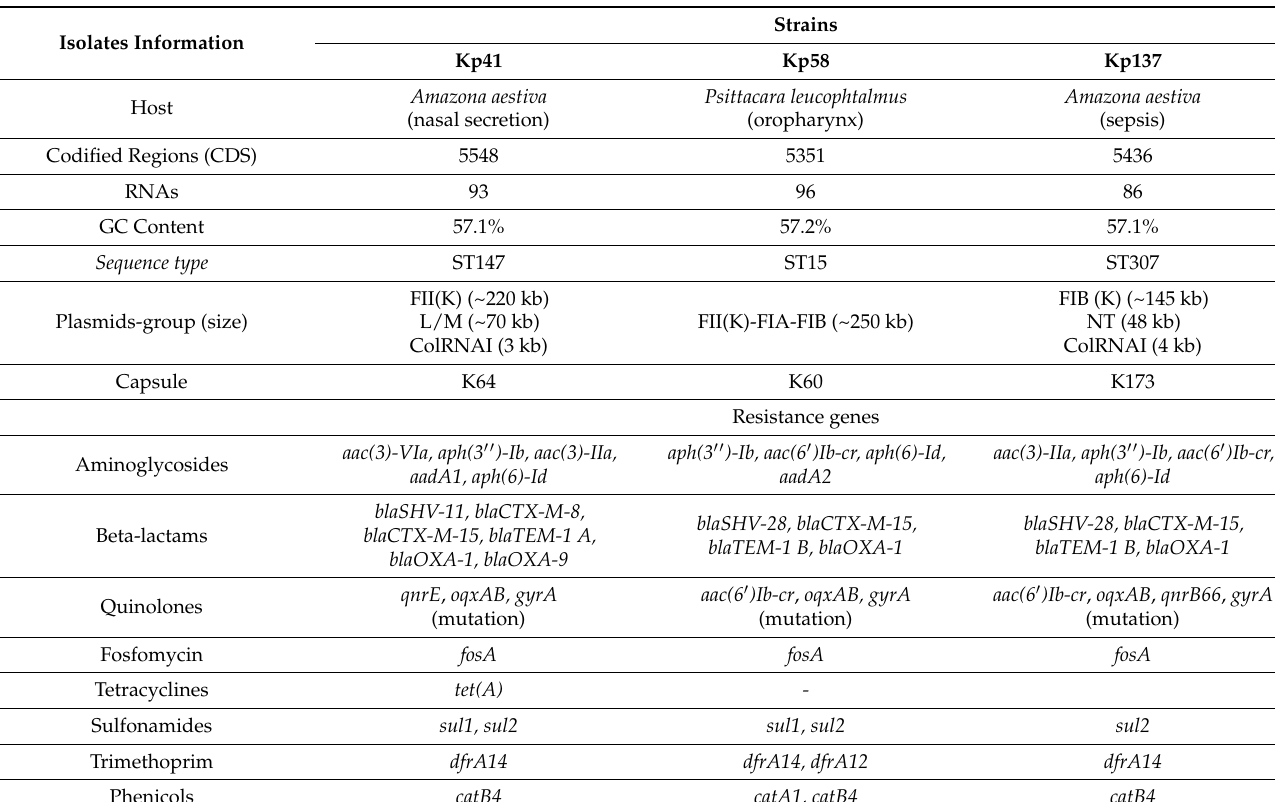
Table 1. Characteristics and genomic data of K . pneumoniae strains infecting companion birds.